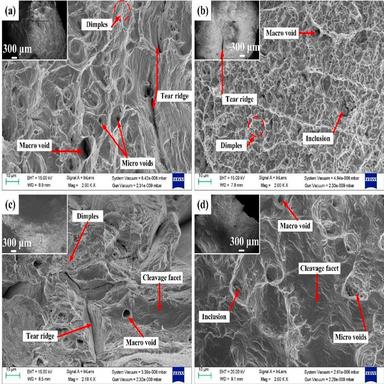
Fractography SEM micrographs of (a) AW state standard tensile specimen; (b) PWHTtate standard tensile specimen; (c) AW state subsize tensile specimen; (d) PWHT state subsize tensile specimen.